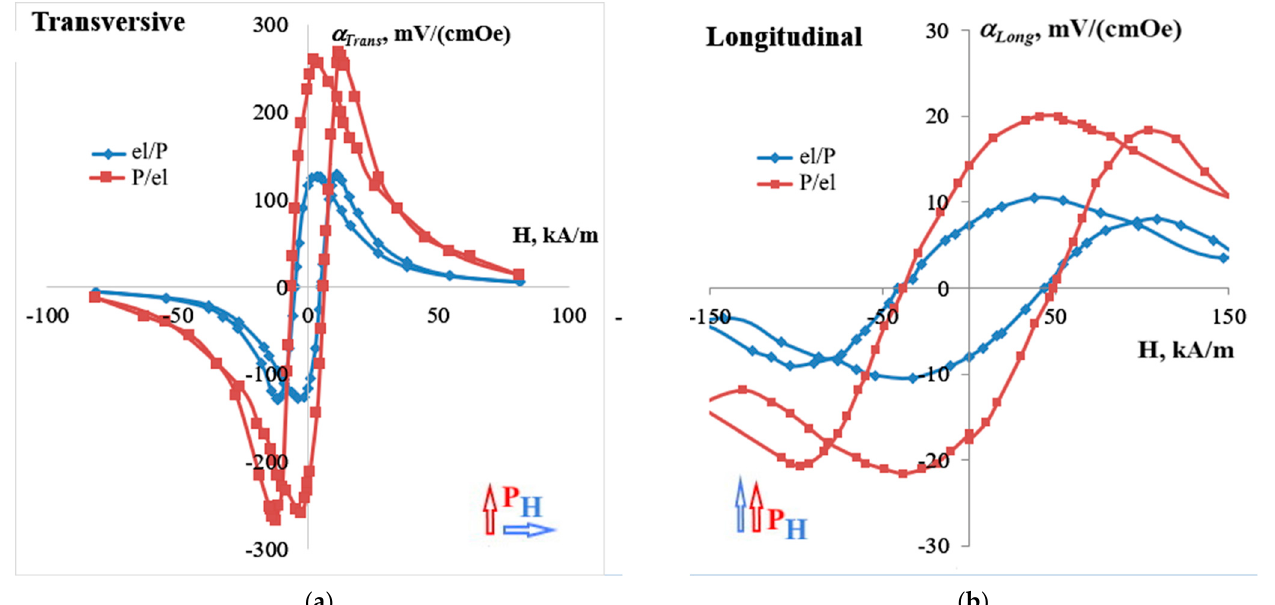
Figure 2. Linear magnetoelectric e ff ect in samples coated with nickel with a thickness of 50 µm on each side: ( a ) for transverse orientation; ( b ) for longitudinal orientation. Experimental data on the ME coe ffi cient of nickel-PZT-nickel layered structures ob- tained in a magnetic fi eld are shown in Figure 3.